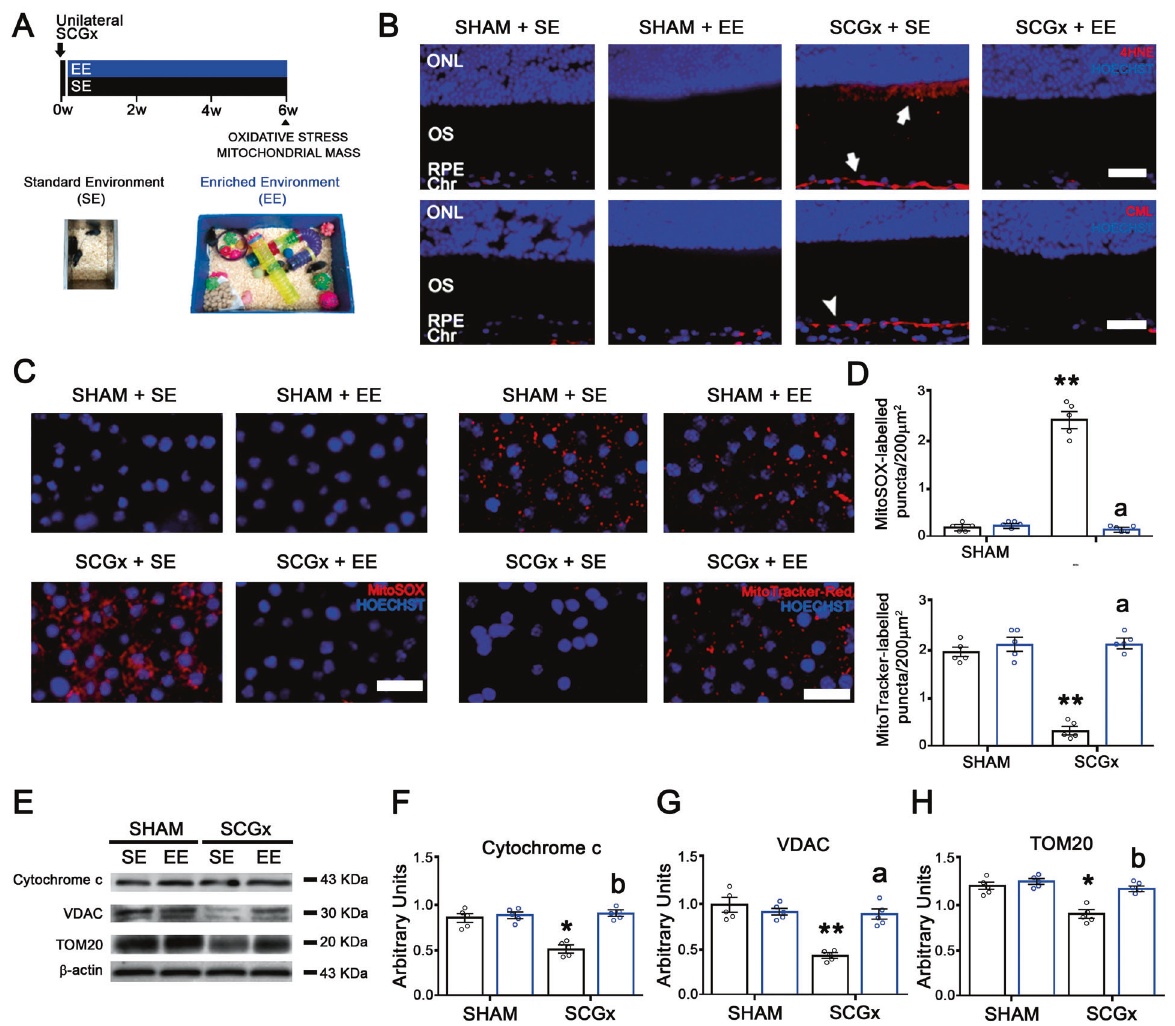
Fig. 3 Effect of EE on the temporal outer retina/RPE oxidative damage, and RPE mitochondria mass at 6 weeks post-SCGx. A Experimental protocols. B EE prevented the SGCx-induced increase in 4HNE- and CML-immunoreactivity at the outer retina/RPE (arrow), and RPE (arrowhead), respectively. Shown are representative photomicrographs from 5 eyes/group, at 800 μ m temporally from the ONH. ONL outer nuclear layer, OS photoreceptor outer segments, RPE retinal pigment epithelium, Chr choroid. Scale bars: 30 μ m. C EE signi fi cantly prevented both the SCGx-induced increase in MitoSox-Red-labelled mitochondria and decrease in Mitotracker-Red( + ) puncta at the RPE (quanti fi ed in D ). Shown are representative photomicrographs from fi ve eyes/group, at 800 μ m temporally from the ONH. Scale bars = 20 μ m. Data are mean ± SEM ( n : 5 eyes per group), ** P < 0.01 vs. sham-treated eyes from SE animals; a: P < 0.01 vs. SCGx-treated eyes from SE animals, by Tukey ’ s test. E – H SCGx induced a decrease in the levels of cytochrome c , VDAC, and TOM20 at the temporal RPE, which were prevented by EE. Data are mean ± SEM ( n : 5 homogenates per group), ** P < 0.01, * P < 0.05 vs. sham-treated eyes from SE animals; a: P < 0.01, b: P < 0.05 vs. SCGx- treated eyes from SE animals, by Tukey ’ s